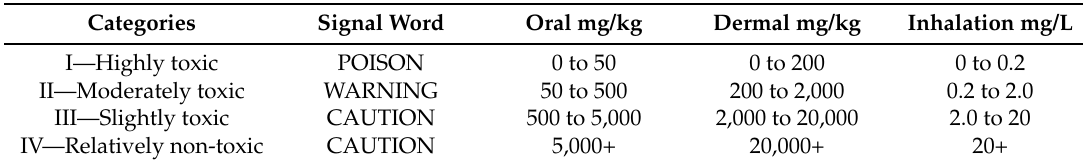
Table 2. Types of acute toxicity measures and warnings